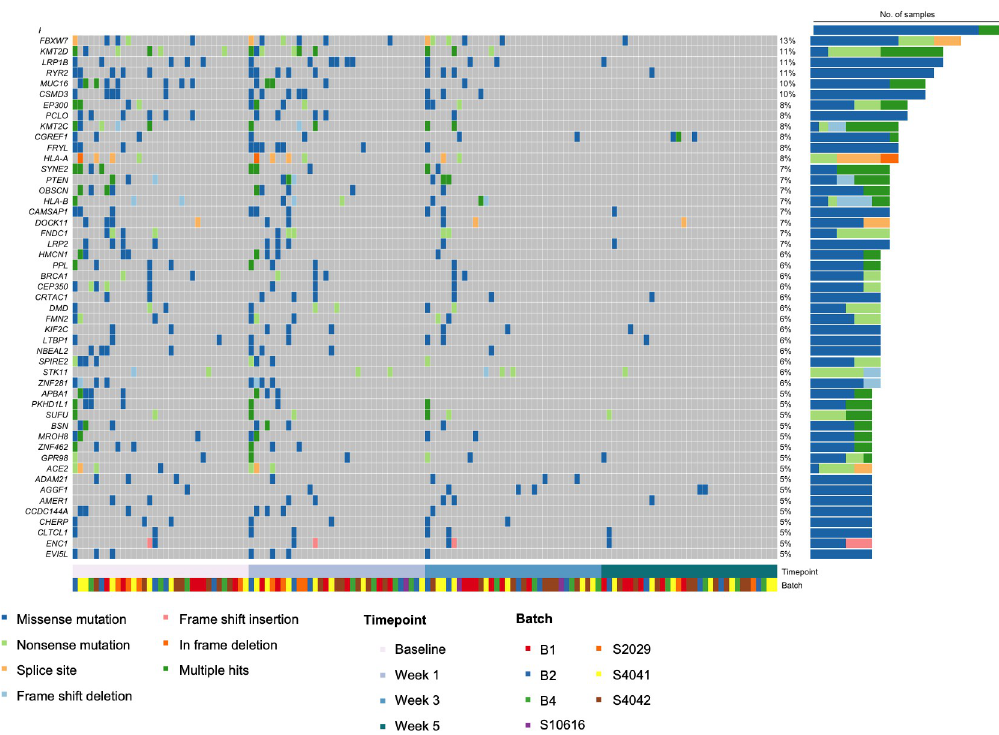
Fig 5. Top 50 gene alterations over time for 33 patients with all four-time points. Heat map displaying the top 50 genes ranked by occurrence for 33 patients (132 samples) grouped by timepoint collection during chemoradiation.